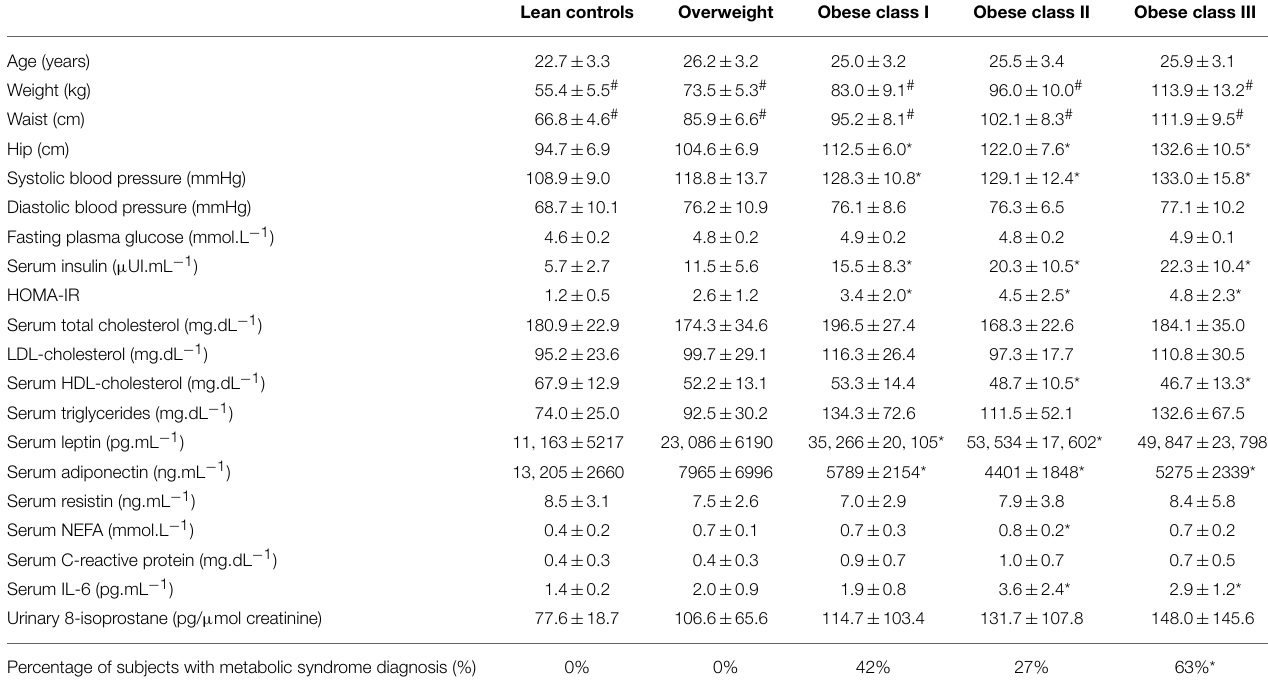
Lean controls Overweight